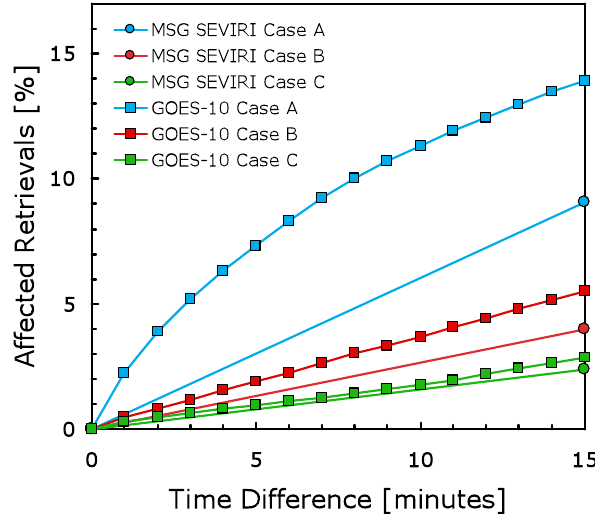
Fig. 5. Percentage of affected trace gas retrievals as function of the time difference between t 0 and t 1 for Case A (blue), B (red) and C (green) for the study using 15min MSG SEVRI data (marked with filled circles) and for the study using 1min GOES-10 data (marked with black